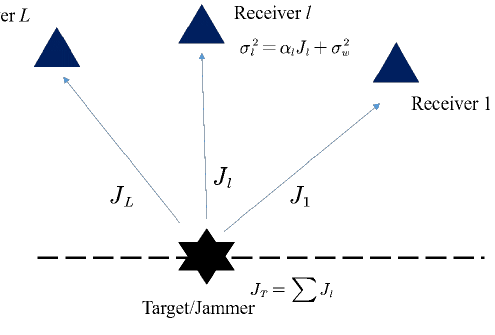
Figure 2. Power allocation of the